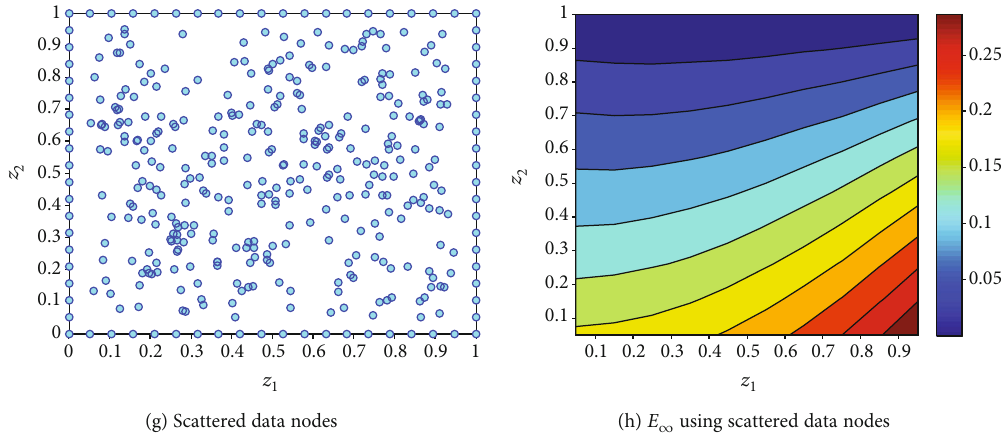
ff erent nonuniform nodes for the Problem Figure 16: E ∞ with di